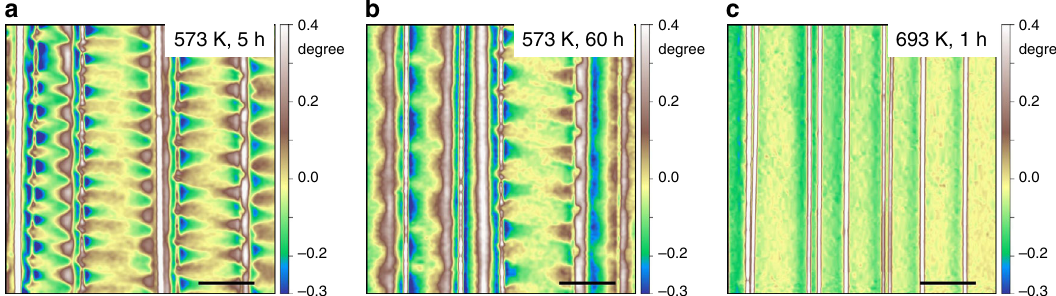
Fig. 5 Evolution of magnetic domains after annealing. a MFM phase image after annealing at 573 K for 5 h. b MFM phase image after annealing at 573 K for 60 h. c MFM phase image after annealing at 693 K for 1 h. The white lines, caused by the jump of the MFM tip, stand for the shear band positions. Scale bar, 10 µ m in a – c